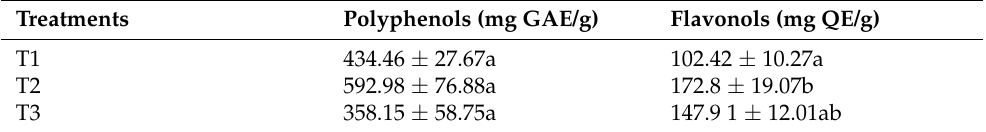
Table 4. Mean ± SE total polyphenol (mg GAE/g) and flavonol (mg GAE/g) contents of leaves of H. odoratissimum grown using different cultivation methods.